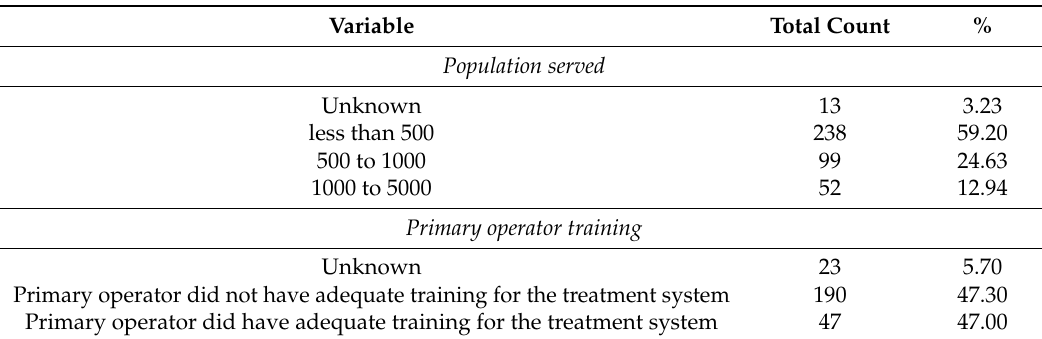
Table 3. Percentage of DWAs by water system characteristics in First Nations community drinking water systems in Ontario,